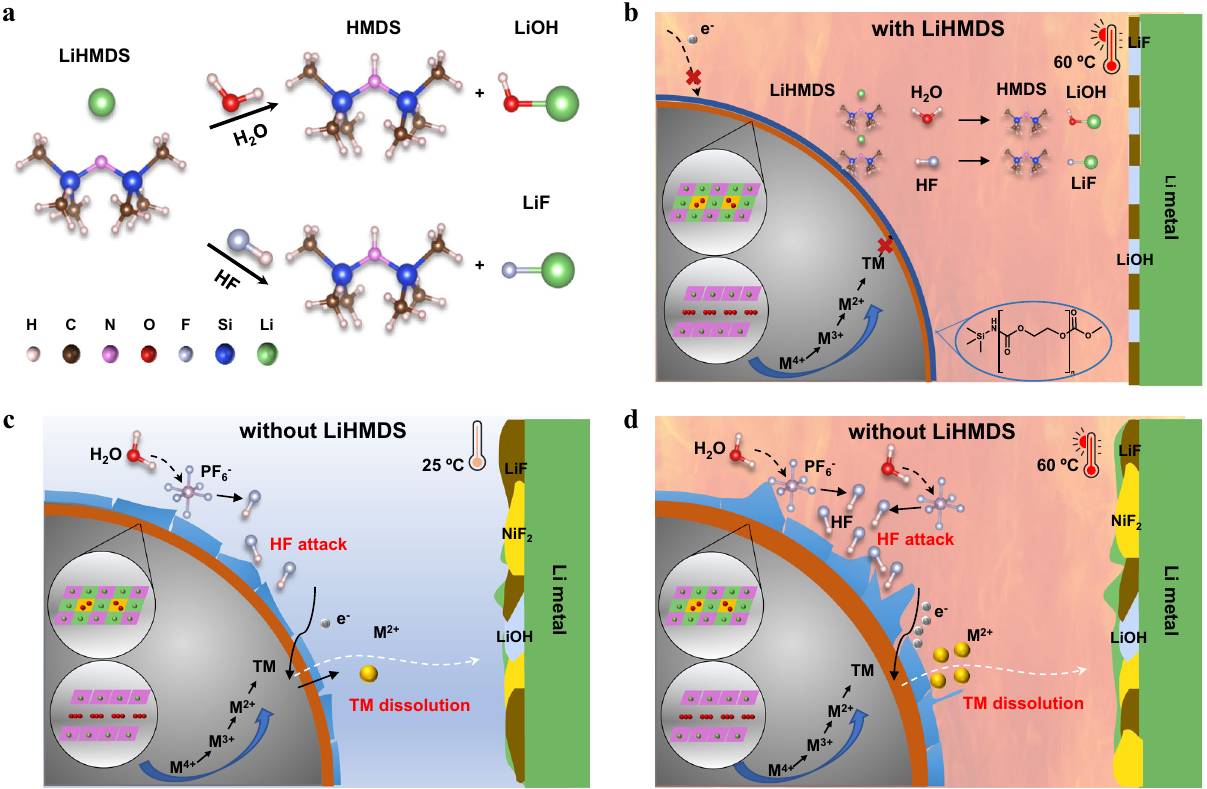
Fig.5|FunctionschematicillustrationofLiHMDSinLi||NCM811cells.a ReactionmechanismofLiHMDSwithHFandH 2 O. b – d WorkingmechanismofLi||NCM811cells with/without LiHMDS cells at 25°C and